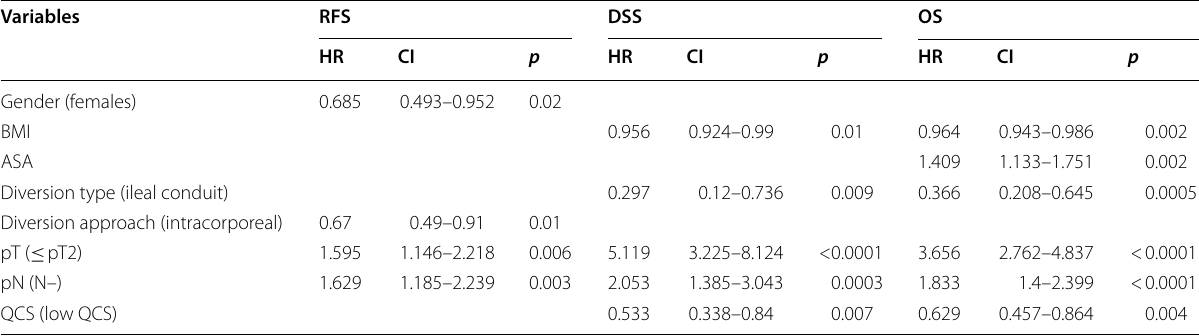
Table 2 Multivariable stepwise Cox proportional hazards regression modeling predictors of RFS, DSS and OS Variables